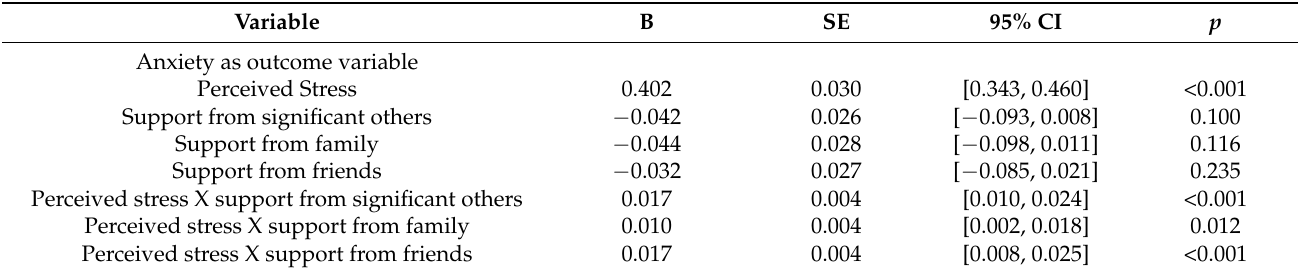
Table 4. The moderating role of dimensions of social